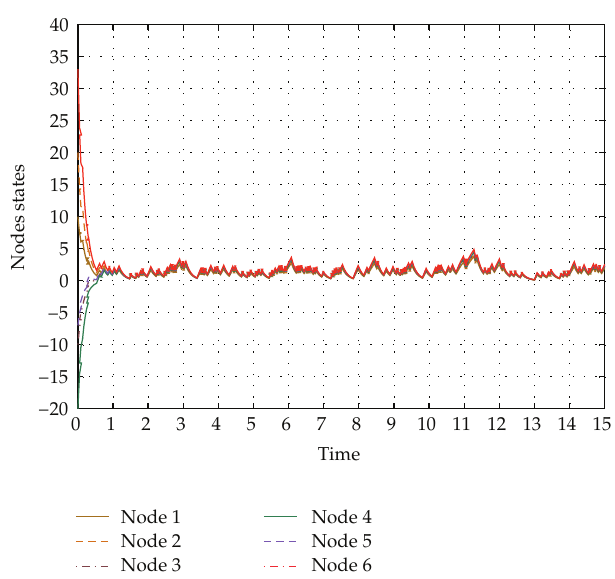
Figure 6: Node state trajectory of multiple equilibria u ∗